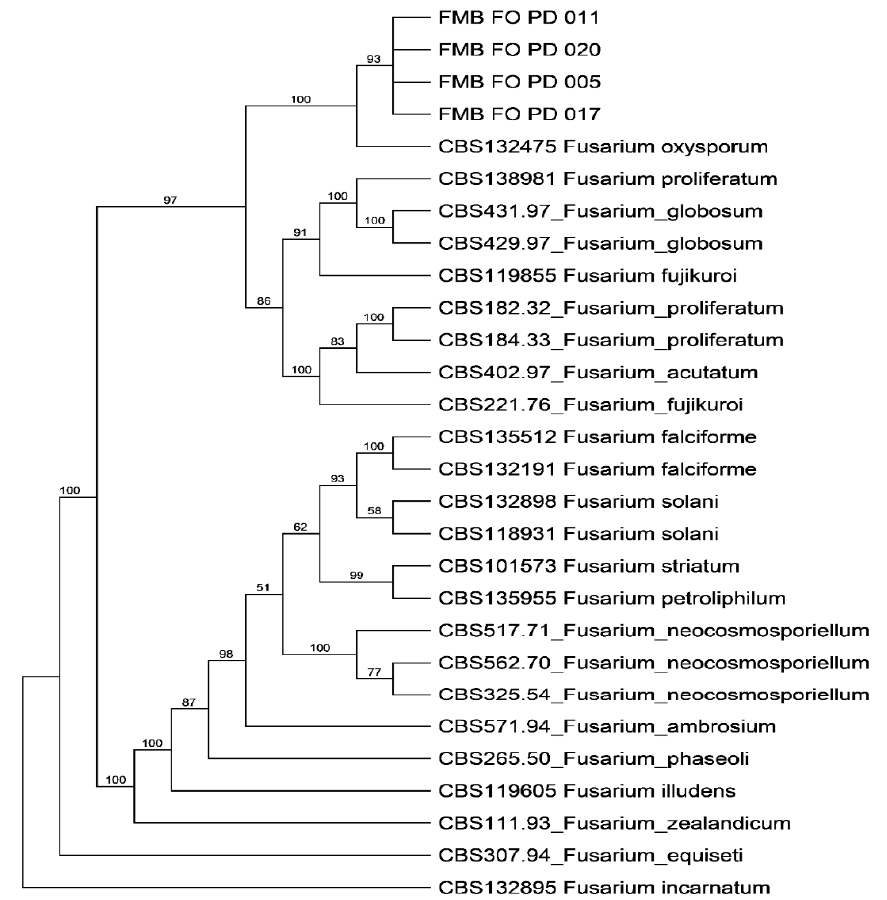
Figure 2. Phylogenetic tree of the concatenated dataset of the internal transcribed spacer (ITS) region, translation elongation factor 1-alpha (TEF1- α ) and RNA polymerase II second largest subunit (RPBII) using PAUP* V4.0 software.